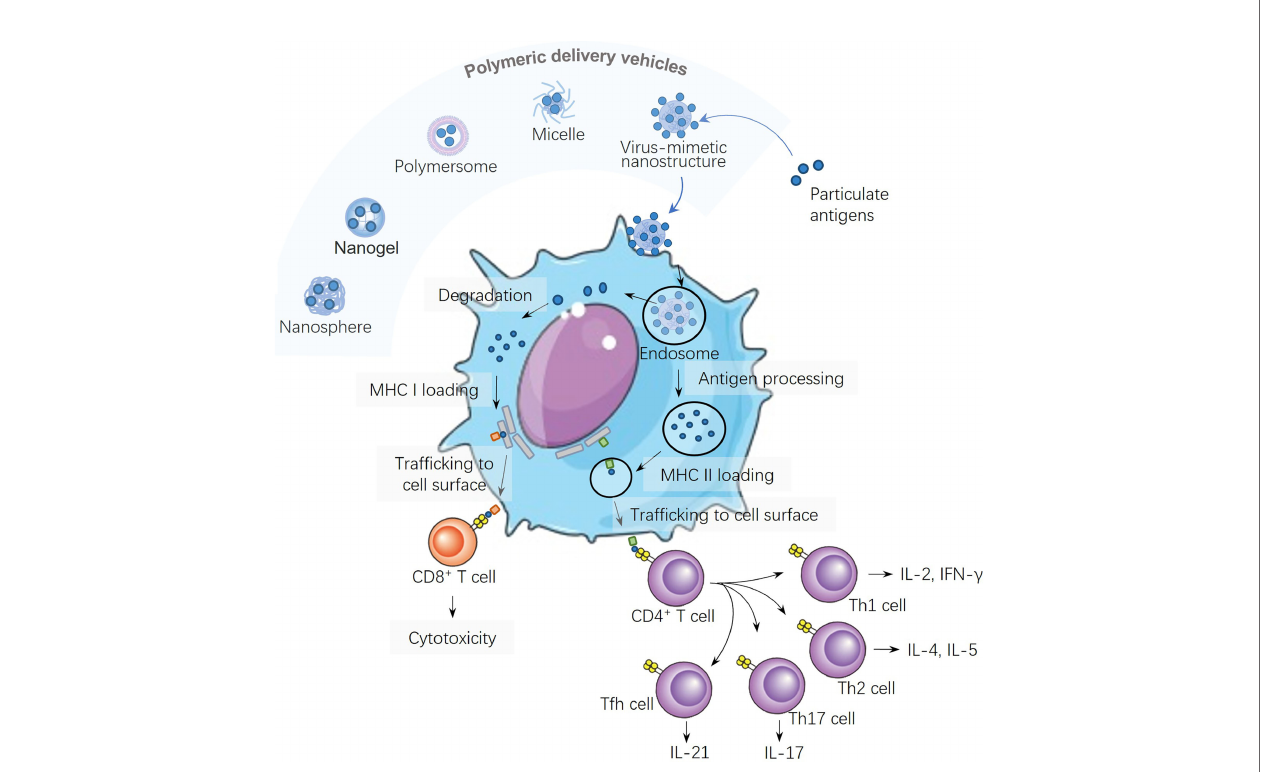
FIGURE 1 | Schematic illustration of different polymeric structures for vaccine development and the antigen processing and presentation of virus-mimetic polymeric nanostructures in a dendritic